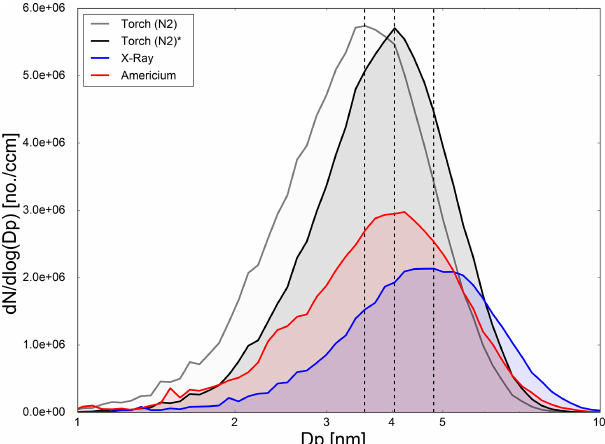
Figure 8. The plot represents the same recorded negative Ag parti- cle number size distribution with a UCPC, depending on the mobil- ity diameter for the plasma torch (N2), X-Ray and americium bipo- lar diffusion chargers. Furthermore, the shift of the size distribution caused by the application of a unsuitable charging efficiency (Torch (N2)) for the plasma torch and the measured charging efficiency (Torch (N2)*) and due to contamination of the X-Ray charger are